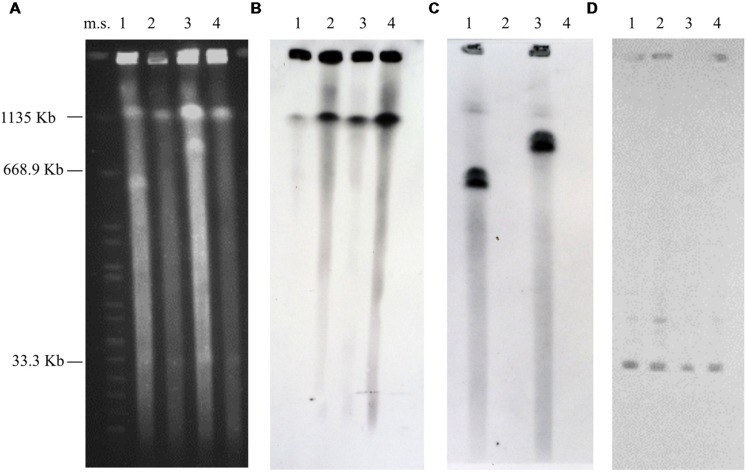
Pulsed-field gel electrophoresis patterns of the undigested genomic DNA of the WT Clostridium butyricum type E strains and their Δmp derivative strains (A), and Southern hybridization analyses using the bont/E gene probe (B), the latt gene probe (C), and the mob gene probe (D). Strains ISS-21 (lane 1), ISS-21Δmp590 (lane 2), ISS-190 (lane 3), and ISS-190Δmp758 (lane 4). Ms, molecular standard, XbaI-digested DNA from Salmonella Braenderup strain H9812 (Hunter et al., 2005).